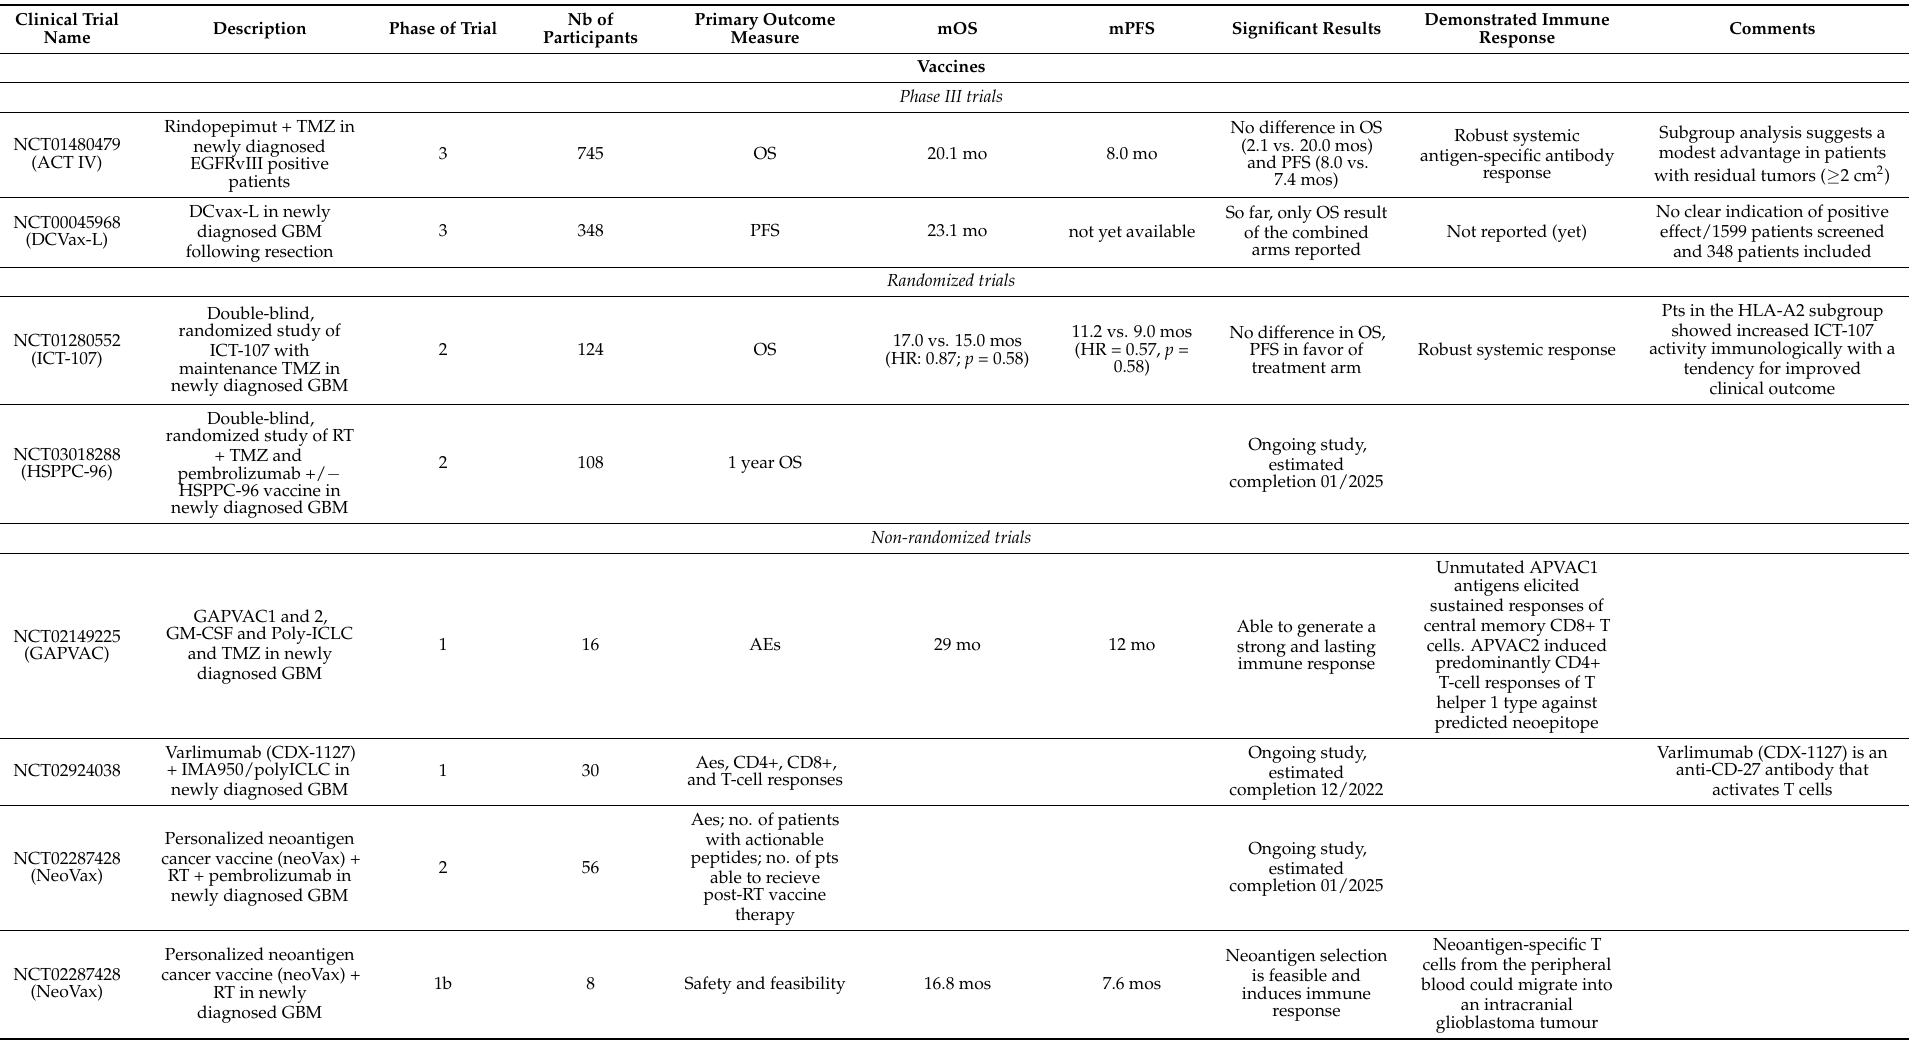
Table 1. Relevant ongoing clinical trials addressing immunotherapies in